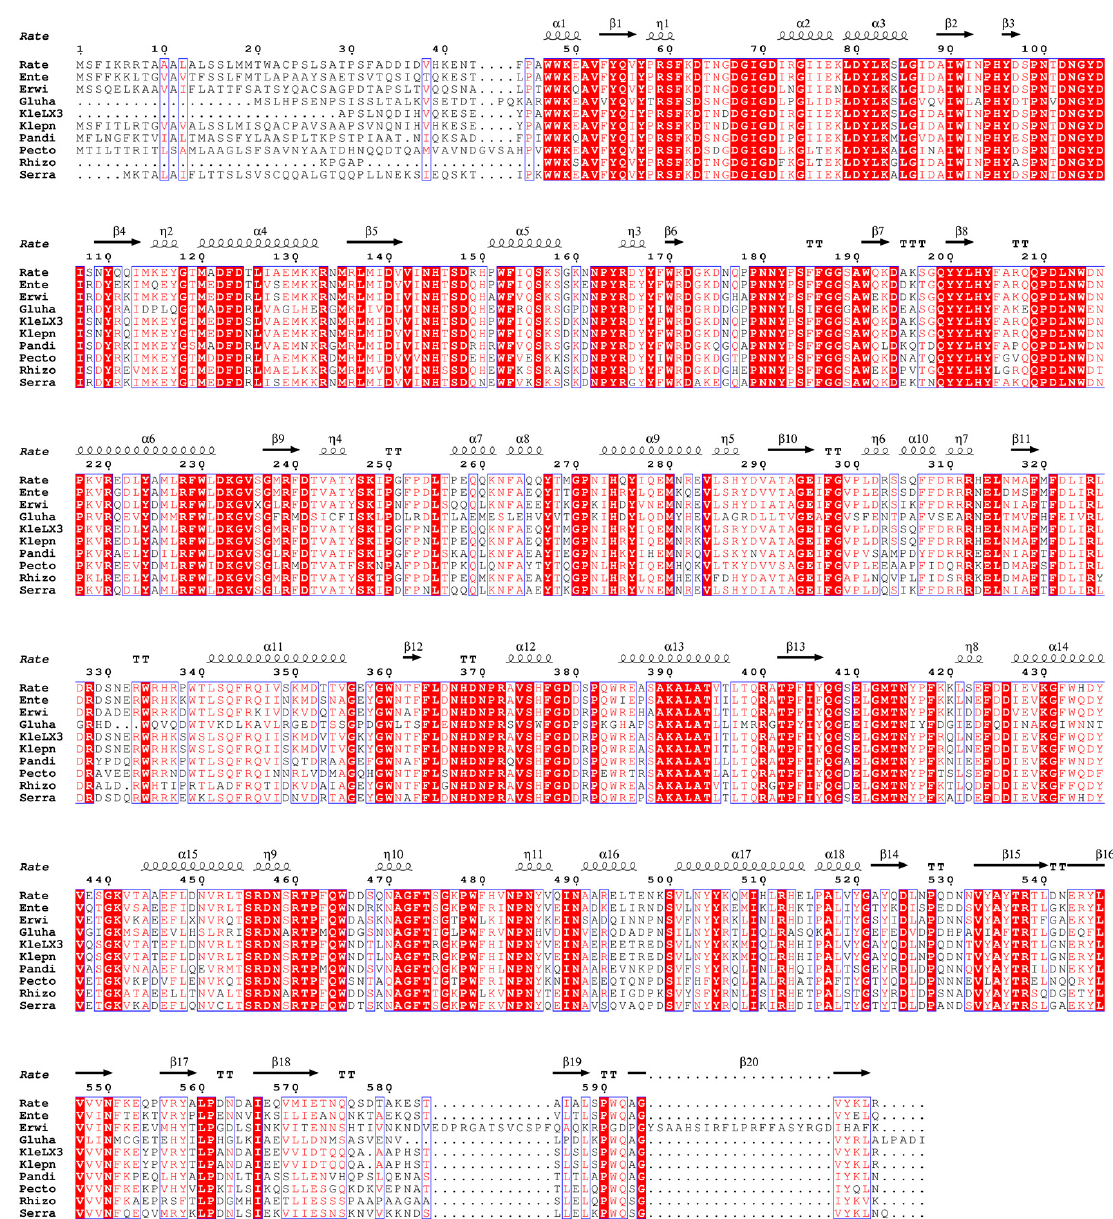
Figure 1. Amino acid sequence alignments of SIases: the strictly conserved areas are shown with a red background and the highly conserved residues are shown using red words surrounded by a blue box.